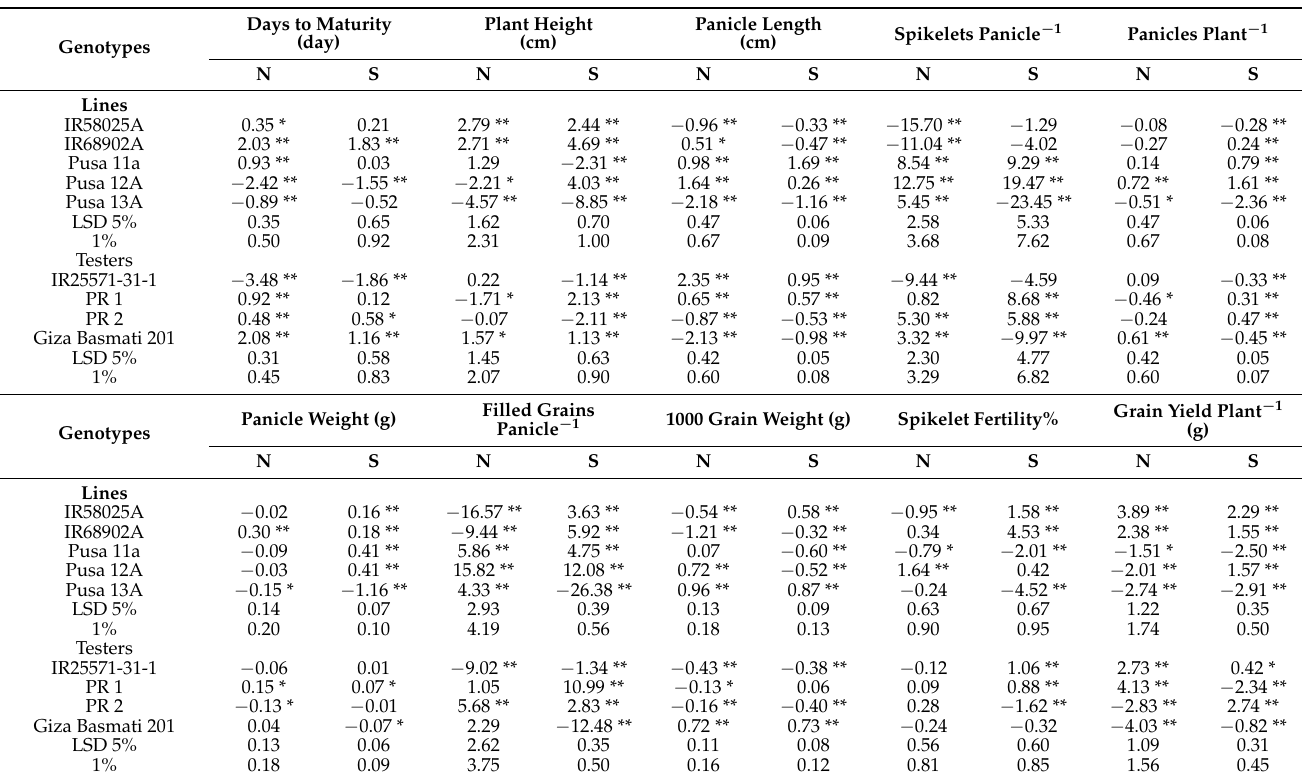
Table 3. Estimation of the General Combining Ability (GCA) Effects of Parental Genotypes for 10 Yield Characteristics Under Normal and Water-Stress